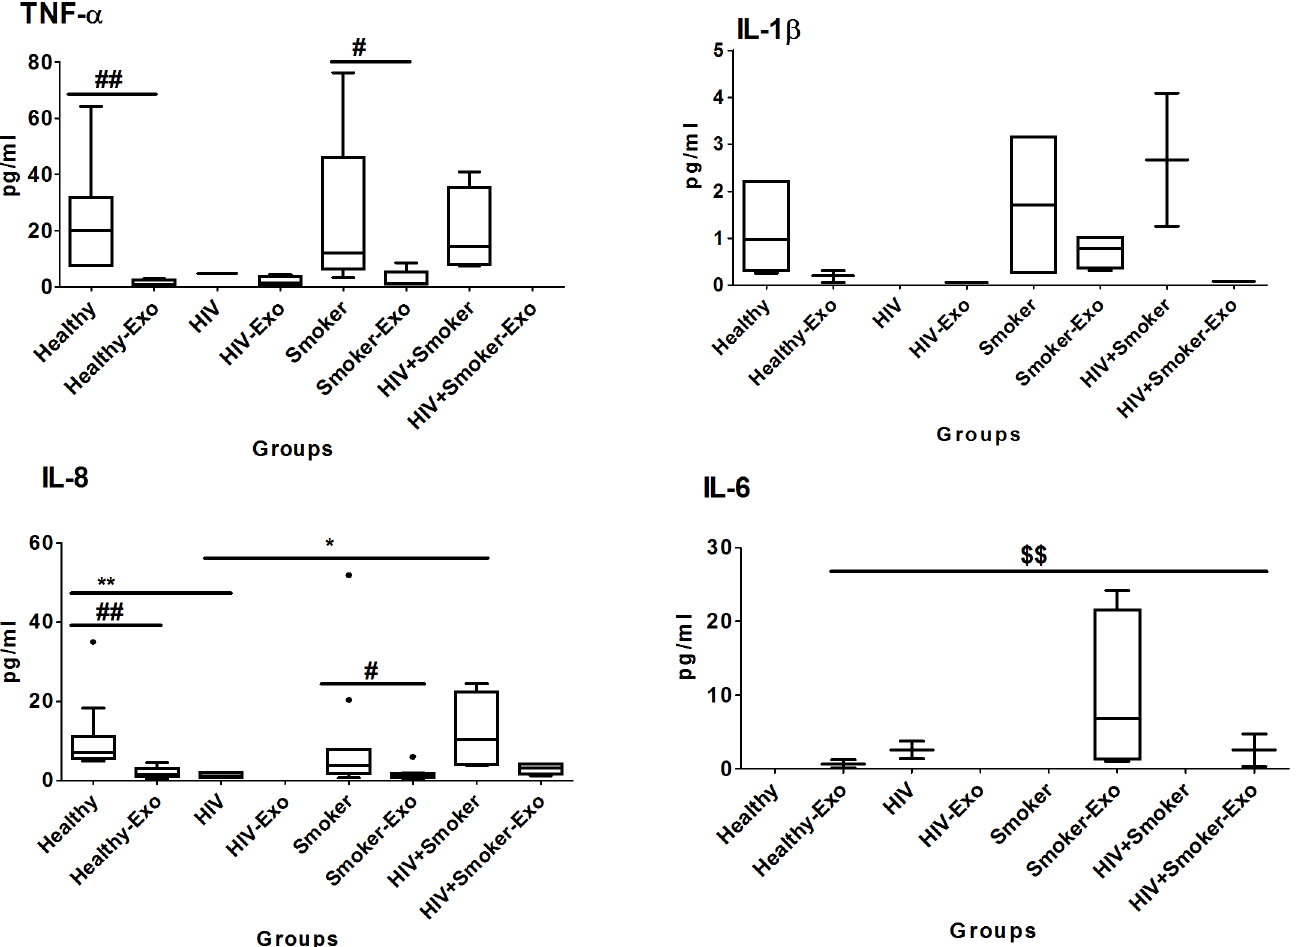
Fig 4. Box and whisker plots of pro-inflammatory cytokines between HIV-negative non-drug abusers (healthy), HIV-positive non-drug abusers (HIV), HIV- negative smokers (smokers) and HIV-positive smoker (HIV+smoker). For comparison with other study groups, the bar graphs for healthy and HIV subjects were replicated from Fig 1. The box represents the 25 th -75 th quartile, the whiskers represent the range of values, the median is presented as a line inside the box, and the out-of-range values are presented as circles. The Mann–Whitney U test was used to compare between plasma and exosomes of different study groups and significant p-values are represented as # (p (cid:20) 0.05) and ## (p (cid:20) 0.01). Comparison of cytokine levels among plasma as well as exosomes of different groups were done using the Mann–Whitney U test and significant p-values are given as (cid:3) (p (cid:20) 0.05), (cid:3)(cid:3) (p (cid:20) 0.01) and $ (p (cid:20) 0.05), $$ (p (cid:20) 0.01), respectively.